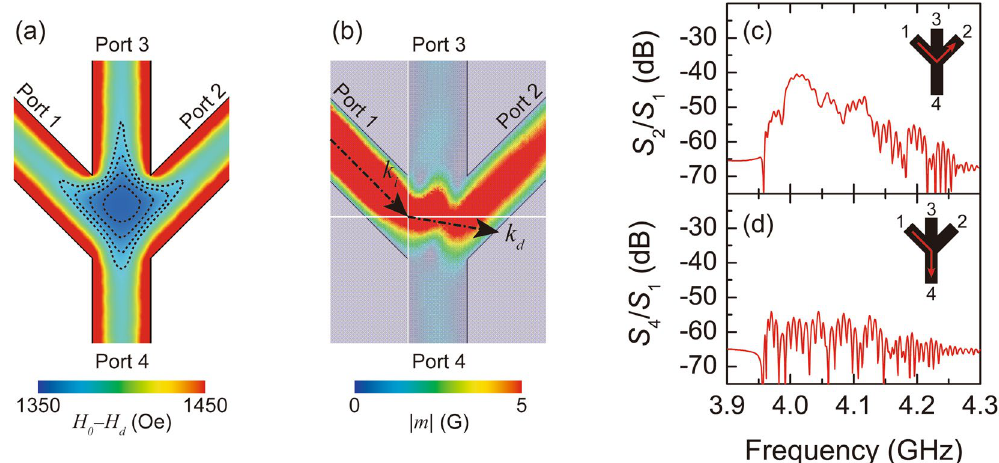
Figure 4. Contribution of demagnetizing field. ( a ) Simulated internal magnetic field with applied field H 0 = 3095 Oe and saturation magnetization 4 π M S = 1759 G. A contour plot of internal magnetic field within the junction area is overlaid with dotted lines. From the inner region, dotted lines represent internal fields of 1364 Oe, 1370 Oe, 1376 Oe, 1382 Oe, and 1388 Oe. ( b ) Simulated flow of the spin wave injected from port 1 with inhomogeneous demagnetizing field with H 0 = 3095 Oe. Wavenumbers k i and k d are overlaid with θ i = 45°, = 9.6°. Simulated transmission properties of ( c ) S θ d 2 / S 1 and ( d ) S 4 / S 1 . Inset pictures illustrate the flow of spin waves within the